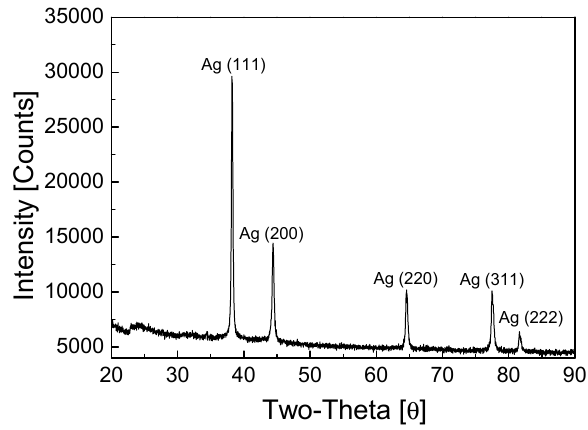
Figure 6. X-ray diffraction profile of deposited Ag. Table 2. Purity of the as-recovered Ag powder.